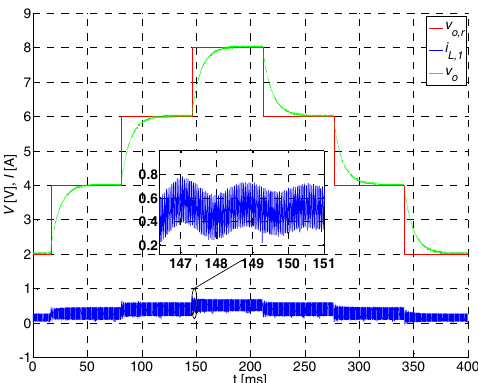
Figure 13. Output voltage and phase 1 current response to 2 V reference voltage steps in the whole operating range.